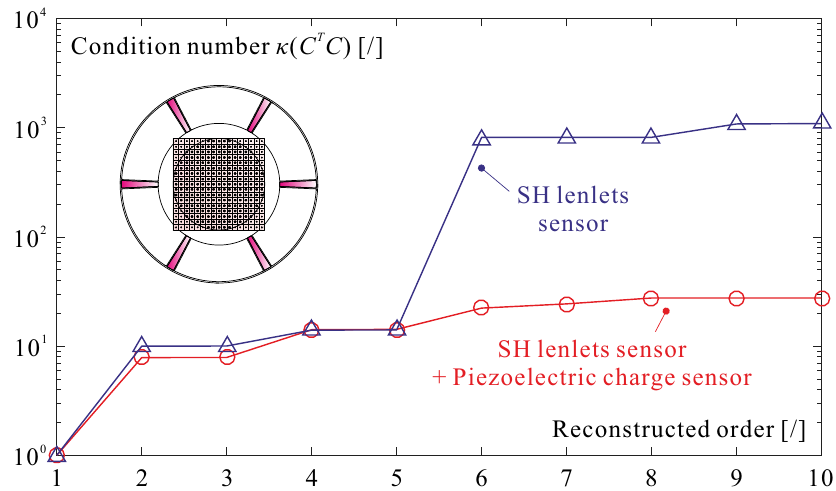
Figure 12. Condition number of κ ( C T C ) as a function of the reconstructed order of the modes, for the SH sensor alone and the sensor combining the SH with 6 PZT radial curvature sensors outside the pupil.